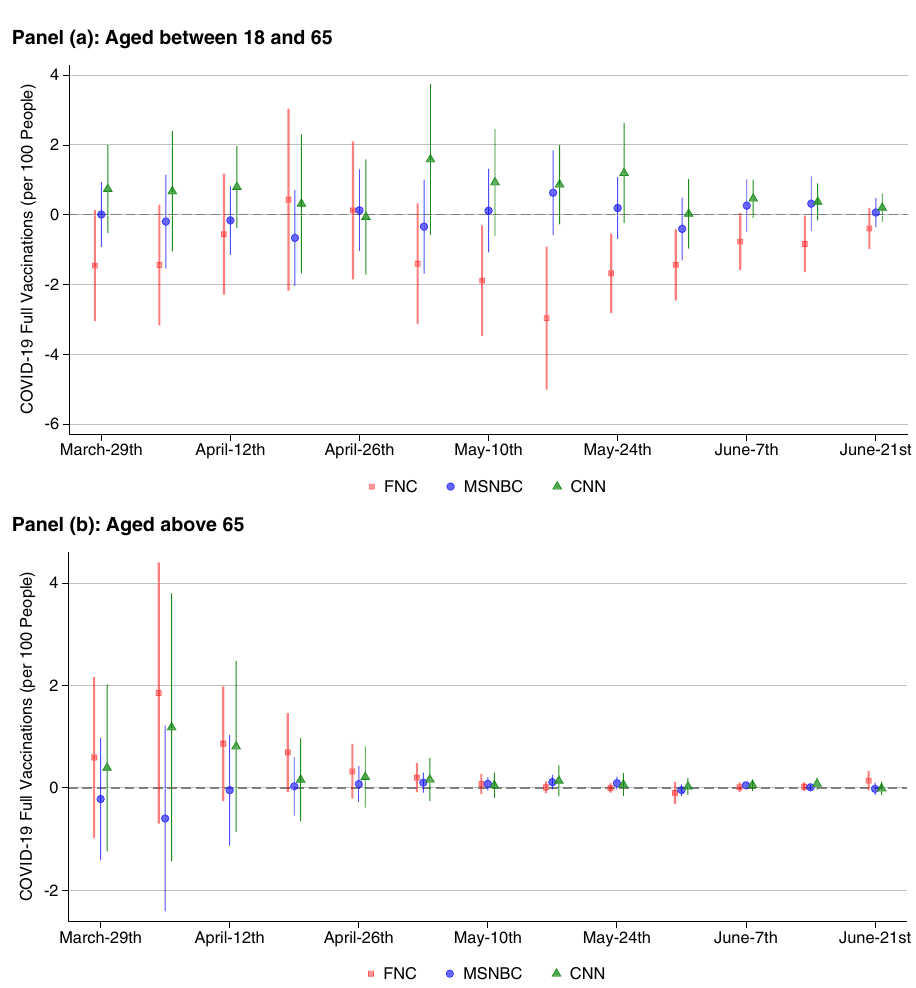
Figure 3. Effect of network viewership on weekly vaccination rates by age group, 2021 (2SLS). Coefficient plots with 95% CIs from 2SLS regressions showing the effect of one standard deviation changes in viewership on weekly vaccinations per 100 people, by age group. Viewerships are instrumented using the lineup channel positions. Regressions include demographic and cable-system controls. Standard errors are clustered by